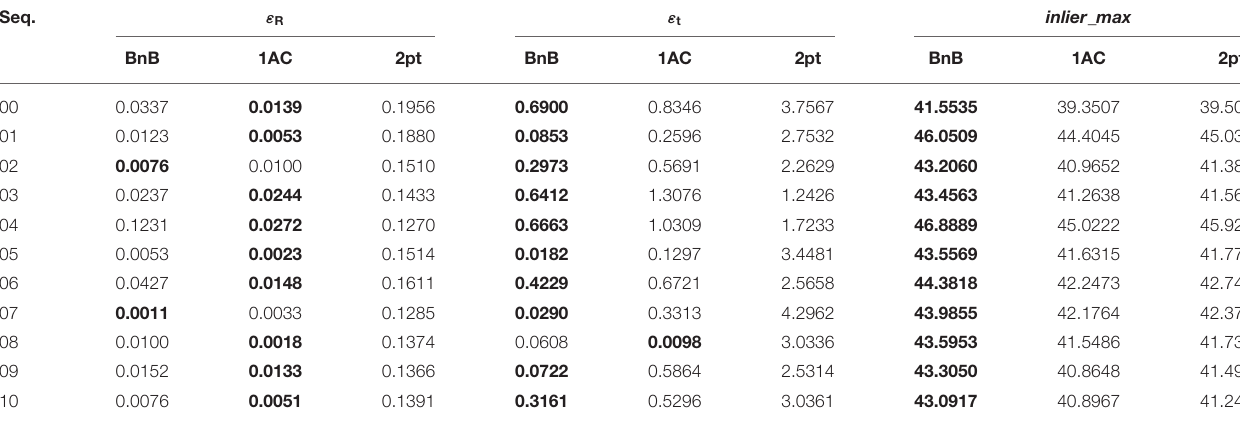
TABLE 1 | Comparison of three methods on 11 sequences of KITTI odometry dataset. Seq.